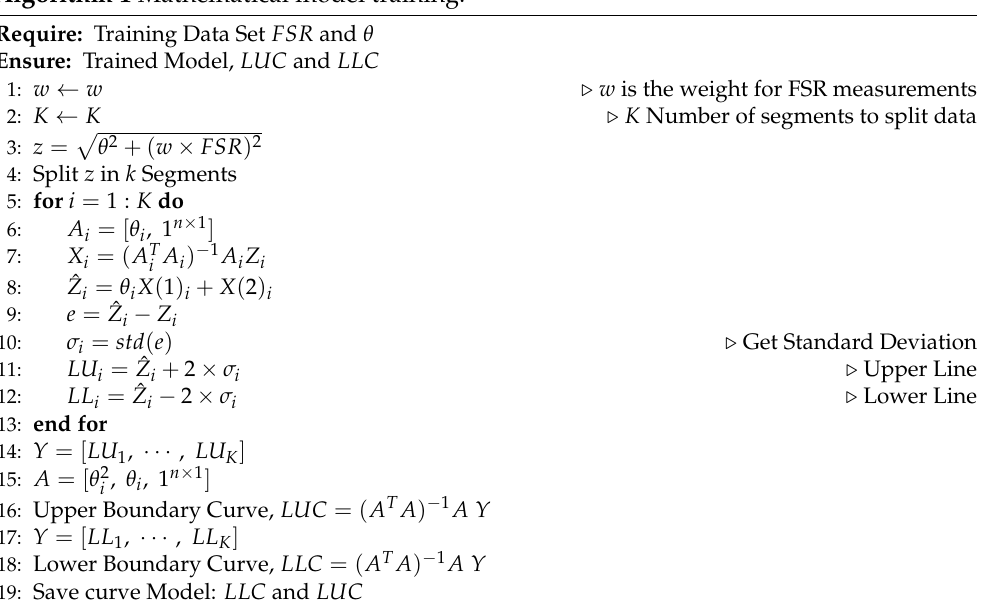
Algorithm 1 Mathematical model